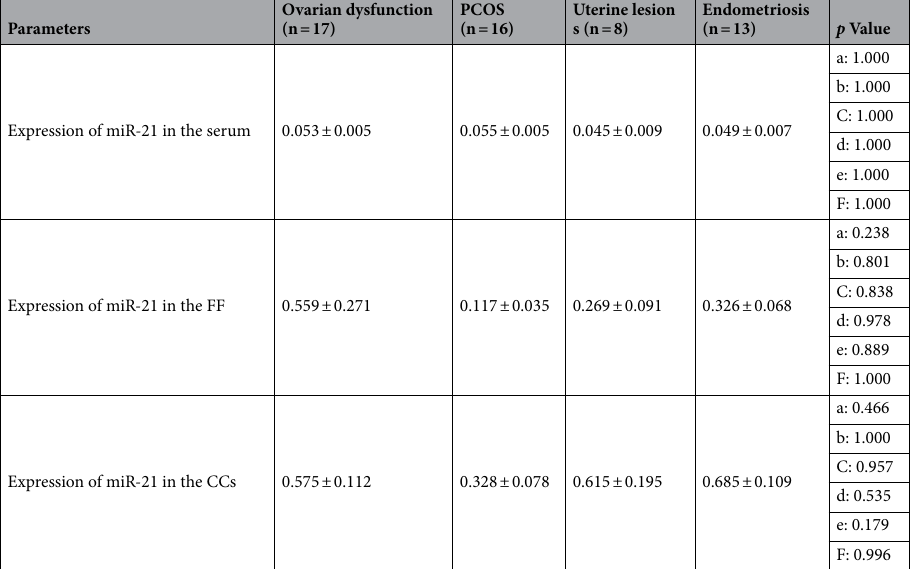
Ovarian dysfunction (n = 17)